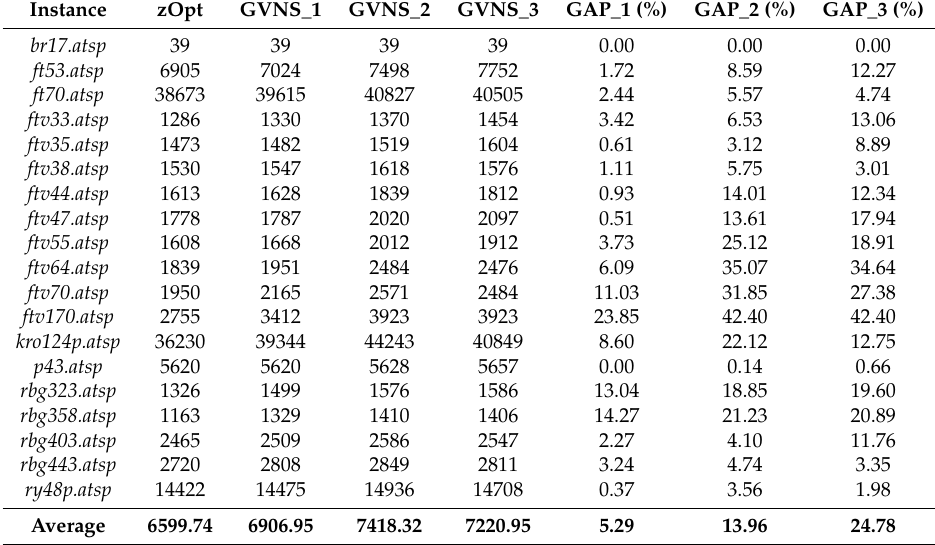
Table 3. Results using the First Improvement search strategy and an execution time limit of 2 min